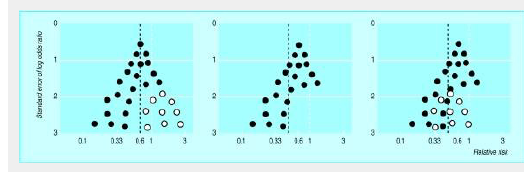
Hypothetical funnel plots: left, symmetrical plot in absence of bias (open circles are smaller studies showing no beneficial effects); centre, asymmetrical plot in presence of publication bias (smaller studies showing no beneficial effects are missing); right, asymmetrical plot in presence of bias due to low methodological quality of smaller studies (open circles are small studies of inadequate quality whose results are biased towards larger effects). Dotted black lines are pooled summary estimates. Pooled estimates exaggerate treatment effects in presence of bias (from Sterne et al. Investigating and dealing with publication and other biases in meta-analysis. BMJ. 2001;323:101–5. Reprinted with the permission from BMJ Publishing Group